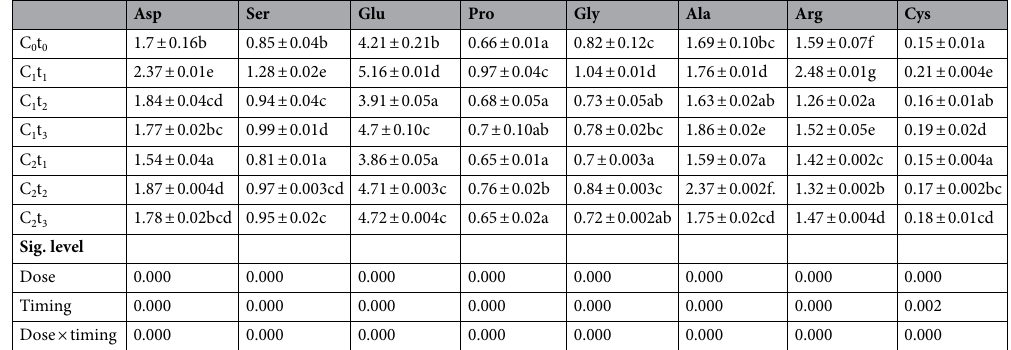
Table 6. Non-essential amino acids (% dw) of P. ostreatus mushrooms cultivated on supplemented substrates. C Pro proline, Gly glycine, Ala Alanine, Arg arginine, Cyst cysteine, do dose, tim timing. Values are means; means within the same column followed by the same letters are not significantly different at P < 0.05 according to Duncan’s multiple range